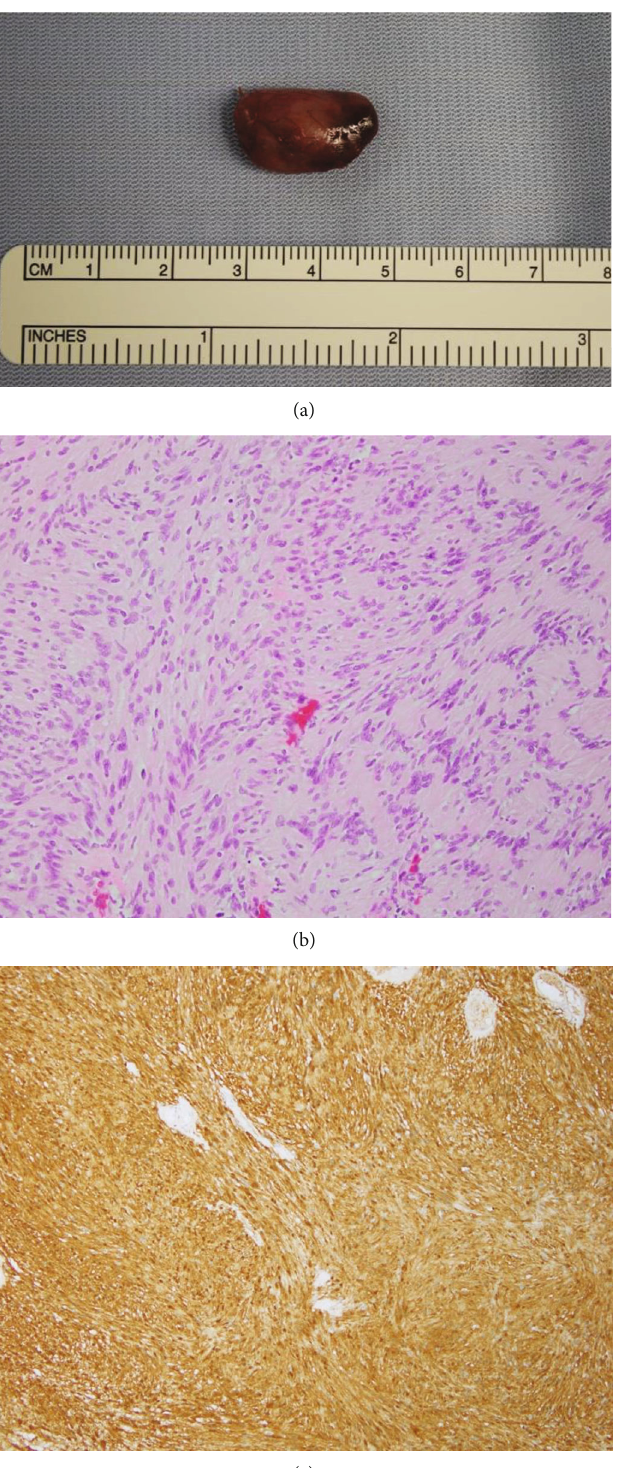
Figure 3: A well-capsulated, dark-reddish tumor was resected in an en bloc fashion (a). Histological images (b) showing Antoni A-positive areas composed of spindle cells with nuclear palisading (hematoxylin and eosin stain). No marked nuclear atypia, mitotic fi gures, or necrosis was seen. S-100 protein was strongly expressed